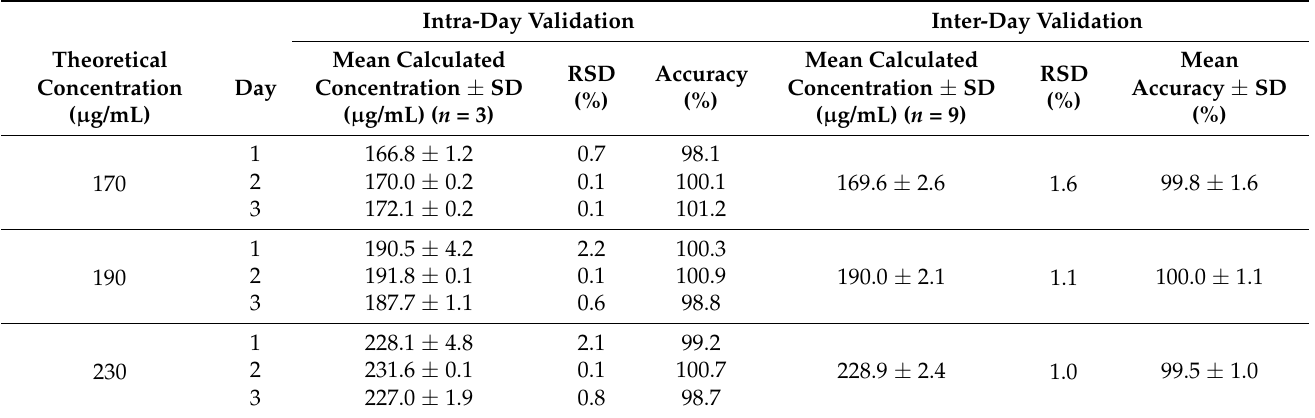
Table 3. Intra and inter-day precision and accuracy results at three concentration levels.